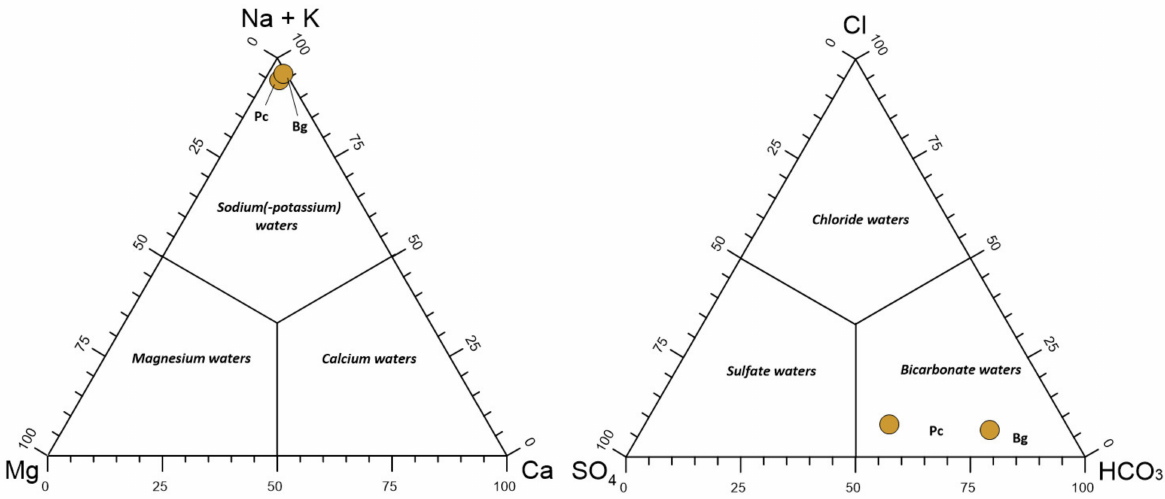
Figure 2. Triangular diagrams of the main cationic and anionic constituents prepared from concentrations in equivalent